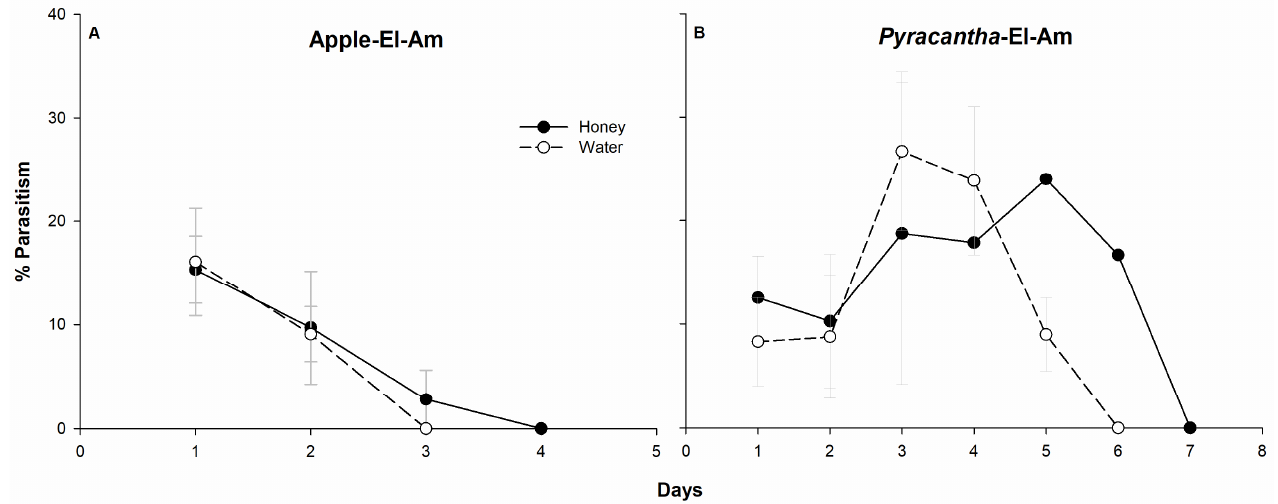
Figure 1. The percentage of parasitism per day by A. mali emerging from E. lanigerum of two HPC (apple trees ( A ) and Pyracantha coccinea ( B )) and exposed to honey and water. The number of pupae produced during the whole parasitoid life (realized fecundity) showed significant differences between the two parasitoid origins (W = 1000; p = 0.024), as Pyracantha -El-Am females produced significantly more pupae (3.46 ± 0.67) than Apple-El- Am (2.59 ± 0.47). There was no significant difference in lifetime realized fecundity (number of pupae produced) between both food sources (water and diluted honey) (W = 930; p = 0.099). On the other hand, fertility (proportion of emerged parasitoids) was similar between both parasitoid origins ( χ 2 = 1.713; df = 1; p = 0.191) and food sources ( χ 2 = 1.980; df = 1; p = 0.159).